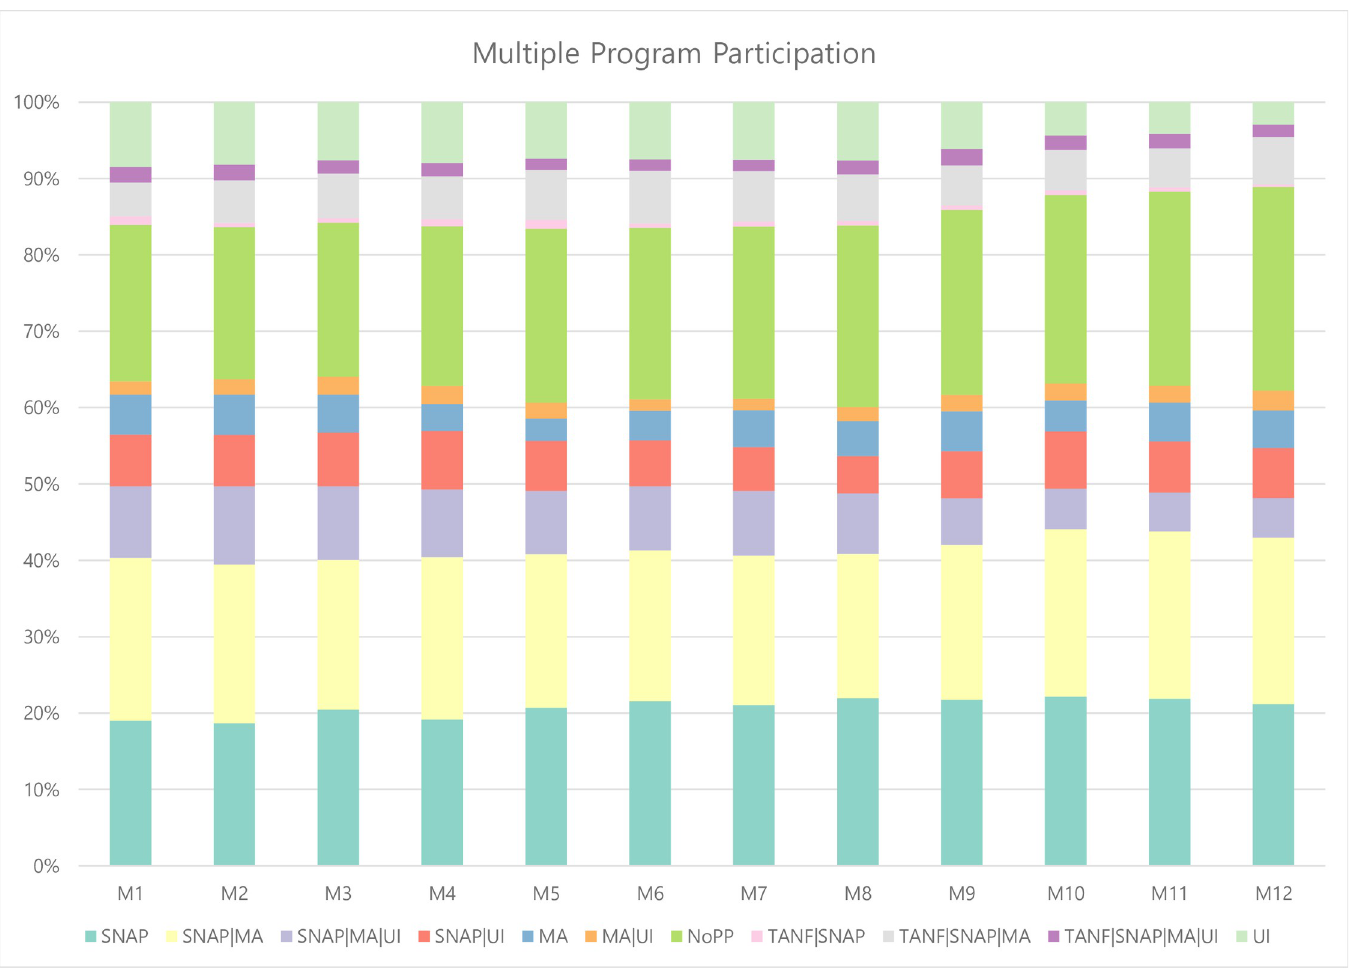
Fig 2. Patterns of multiple program participation after first transition from employment to unemployment. Note . MA = Medicaid; NoPP = No program participation; SNAP = Supplemental Nutrition Assistance Program; TANF = Temporary Assistance for Needy Families; UI = Unemployment Insurance. M1-M12 represent the months after transitioning from employment to